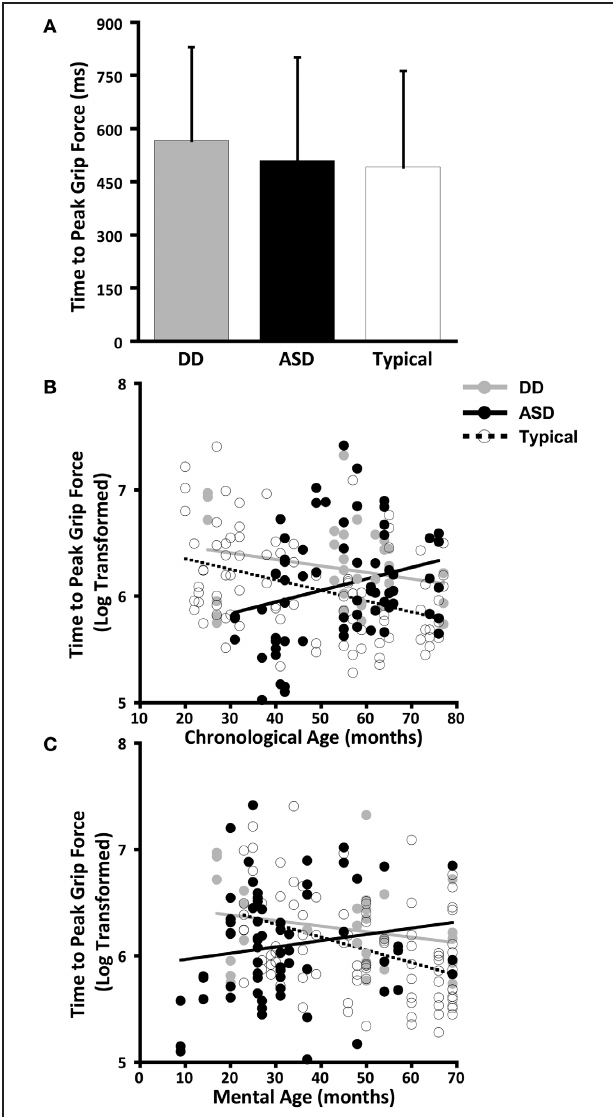
FIGURE 3 | Time to peak grip force. (A) Means and standard deviations. (B) The effect of chronological age. (C) The effect of mental age.